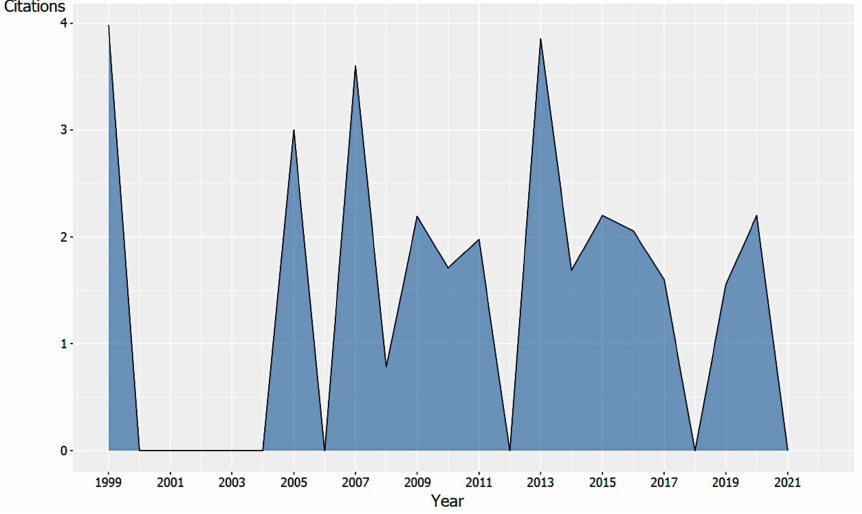
Figure 4. Average article citation per